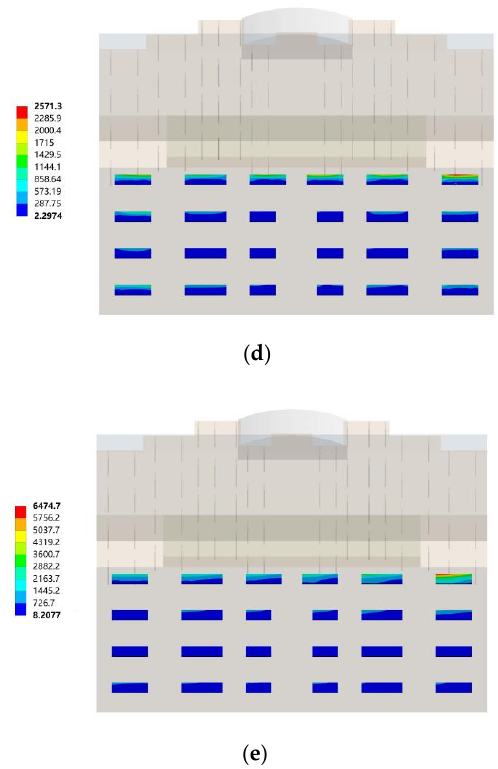
Figure 11. Northwest wind, where the southward horizontal sun visors changed with the orientation of the building. ( a ) Clouds of the sun visors in the south direction; ( b ) Clouds of the sun visors in the direction of south by west 15; ( c ) Cloud map of sun visors in the direction of south by west 30; ( d ) Cloud map of sun visors in the direction of south by east 15; ( e ) Cloud map of the sun visors in the direction of south by east 30.